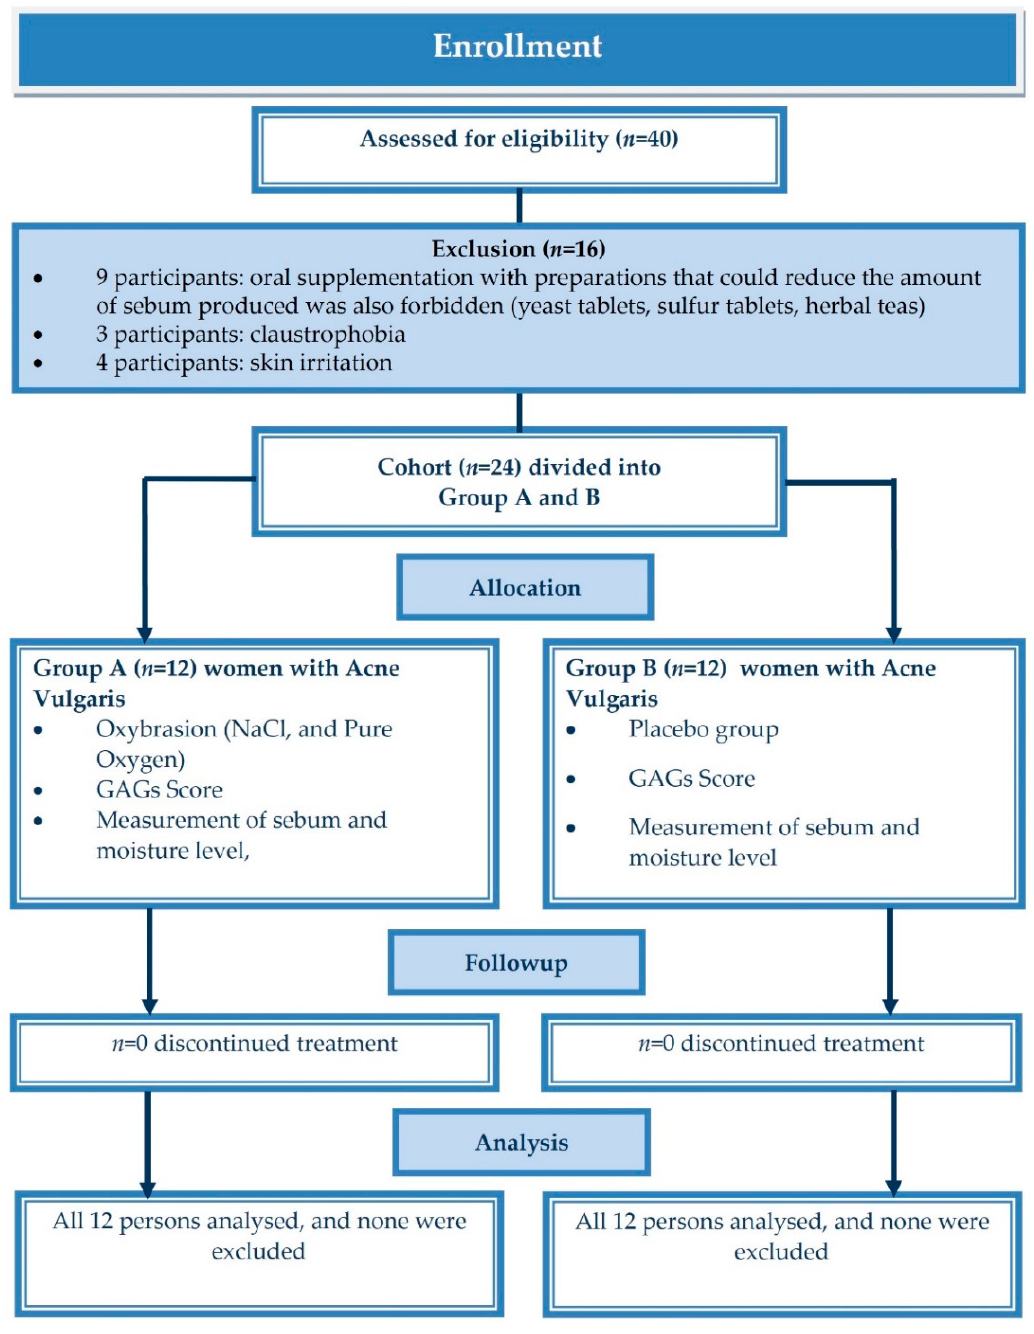
Figure 1. Patient follow in the study.